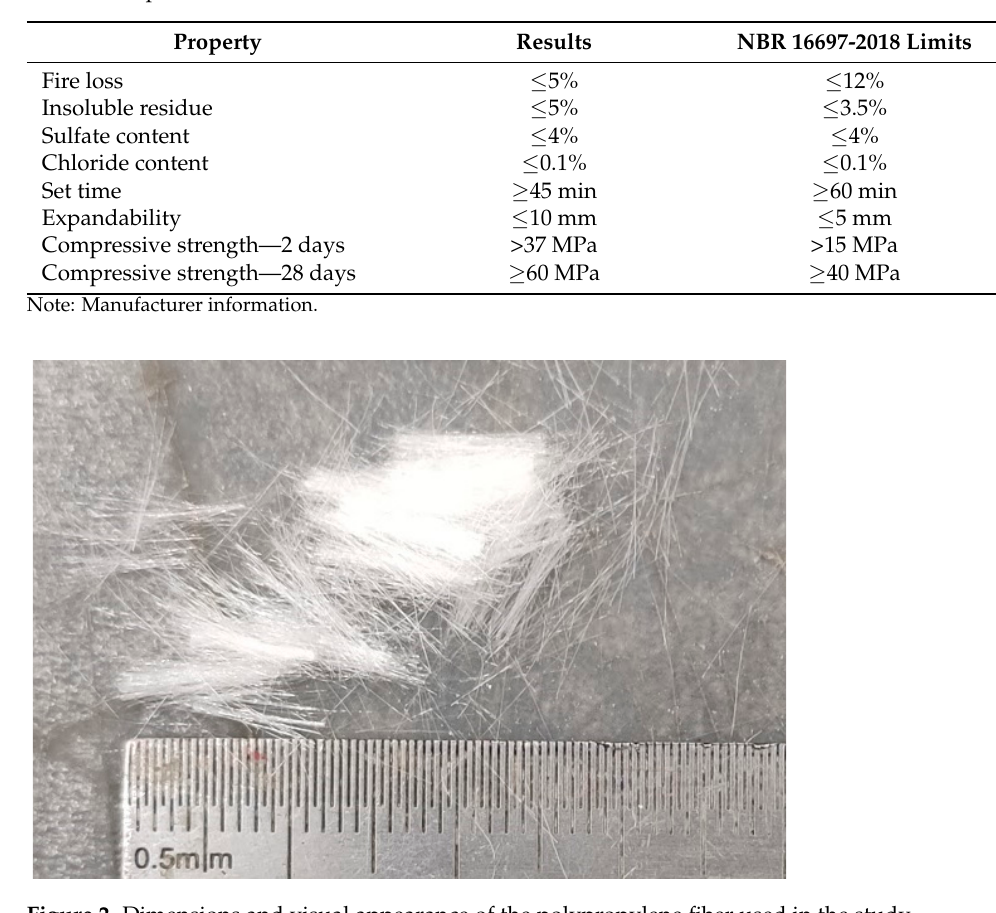
Table 1. Properties of the CPB-40 white Portland cement.